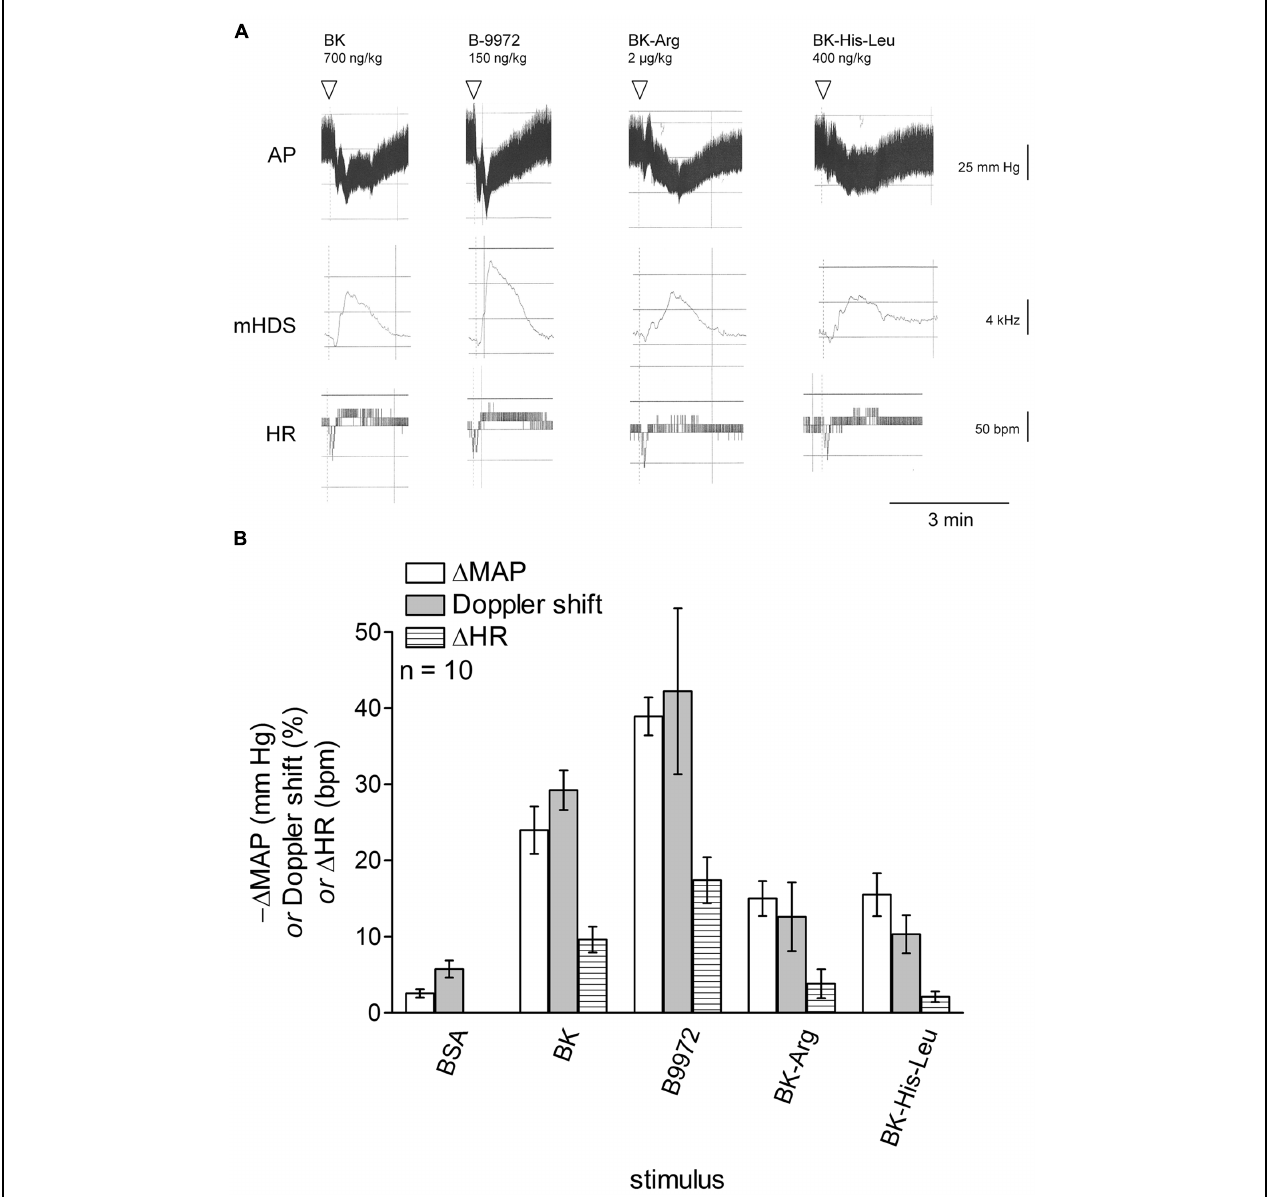
FIGURE 8 | Cardiovascular responses to i.v. bolus injections of BK and three alternate kinin receptor agonists in anesthetized rats. (A) Simultaneous changes in arterial pressure (AP), mean hindquarter Doppler shift (mHDS) signal and HR elicited by i.v. injections of BK, B-9972, BK-Arg, and BK-His-Leu. Abscissa: time; ordinate: AP (mm Hg), mHDS (kHz); HR (beats per minute, bpm). (B) Bar graph showing maximal fall in MAP and rises in mHDS and HR elicited by i.v. injections of vehicle, BK and the three alternate kinin receptor agonists. Abscissa: dose (ng/kg); ordinate: fall of MAP (mm Hg) and rises of mHDS (%) and HR (bpm). Values are means ± SEM. BK (700 ng/kg), B-9972 (150 ng/kg), BK-Arg (2 µ g/kg), and BK-His-Leu (400 ng/kg) were randomly administered as bolus in 10 anesthetized rats (see Materials and Methods). See Results for